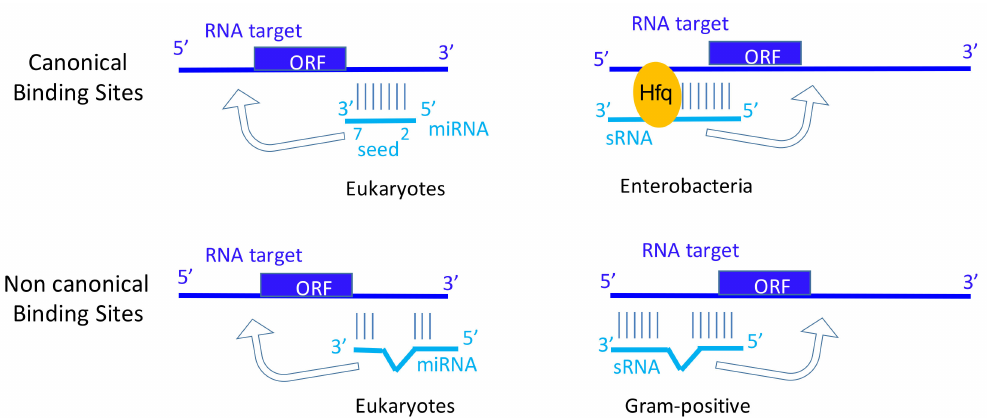
Figure 1. Canonical and non-canonical binding sites for micro RNA (miRNA) and regulatory RNA (sRNA). Target RNAs can be messenger RNAs (mRNAs) (as shown) or other non-coding RNAs (ncRNAs). The miRNA-Induced Silencing Complex (miRISC), containing at least Argonaute proteins, is required for base pairing between seed sequence of the miRNA and the targeted-RNA. For non-canonical binding sites, the nature of the miRISC is poorly studied. In Enterobacteria, Hfq is involved in the base pairing between sRNA and targeted-RNA, in contrast to sRNAs acting in Gram-positive bacteria that usually possess extended pairing domains. miRNAs and sRNAs bind to their target mRNAs at the 3 (cid:48) -UTR (3 (cid:48) -untranslated regions) or translation initiation sites, respectively. However, miRNAs can also bind at 5 (cid:48) UTRs, sRNAs at 3 (cid:48) UTRs, and both miRNAs and sRNAs within coding sequence regions (arrows). ORF: open reading